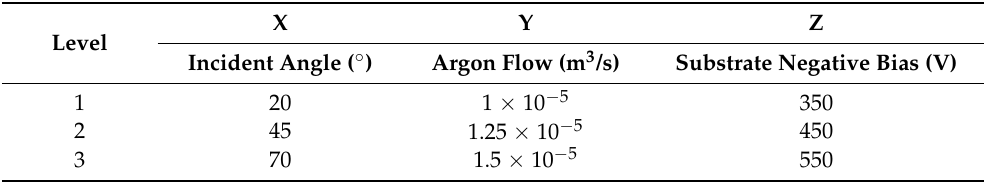
Table 6. Level table of orthogonal test factors for ion beam etching.